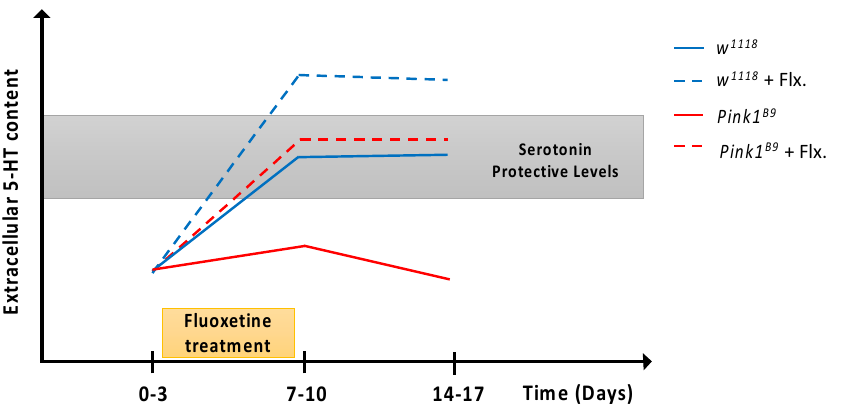
Figure 5. A proposal for the protective vs. toxic effects of serotonin in the fly brain. Schematic representation of the dynamic changes in extracellular 5-HT content proposed to be occurring in the adult fly brain under the different conditions studied. Control flies exhibit a protective/trophic level of 5-HT content (blue line, gray zone), which allows the normal maturation and refinement of neuronal circuits that participate in motor behavior. In Pink1 B9 flies, no protective/trophic 5-HT levels are reached (red line, white zone), hindering the normal maturation and refinement processes, which favors the onset of Parkinsonian phenotypes in aged animals. A transient increase (fluoxetine treatment, yellow box) of extracellular 5-HT levels in mutant flies serves to reach the protective range (red dashed line), permitting the normal maturation and refinement of neuronal circuits and halting the onset of the PD symptomatic phase later in life. On the other hand, in control flies, the fluoxetine treatment (yellow box) results in extracellular 5-HT levels that increase over the normal range (blue dashed line, white zone), disturbing the normal maturation and refinement of circuits, leading to the onset of PD-like phenotypes as animals age.